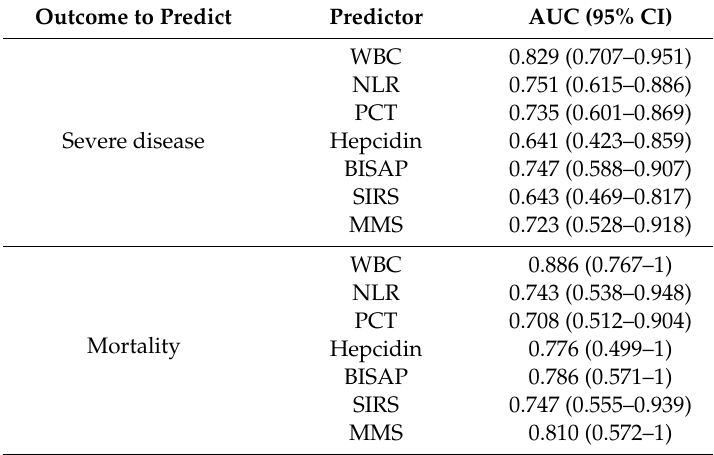
AUC: area under the receiver operating characteristics curve; CI: confidence intervals; MMS: modified Marshall score; NLR: neutrophil / lymphocyte ratio; PCT: procalcitonin; BISAP: bedside index of severity in acute pancreatitis; SIRS: systemic inflammatory response syndrome; WBC: white blood